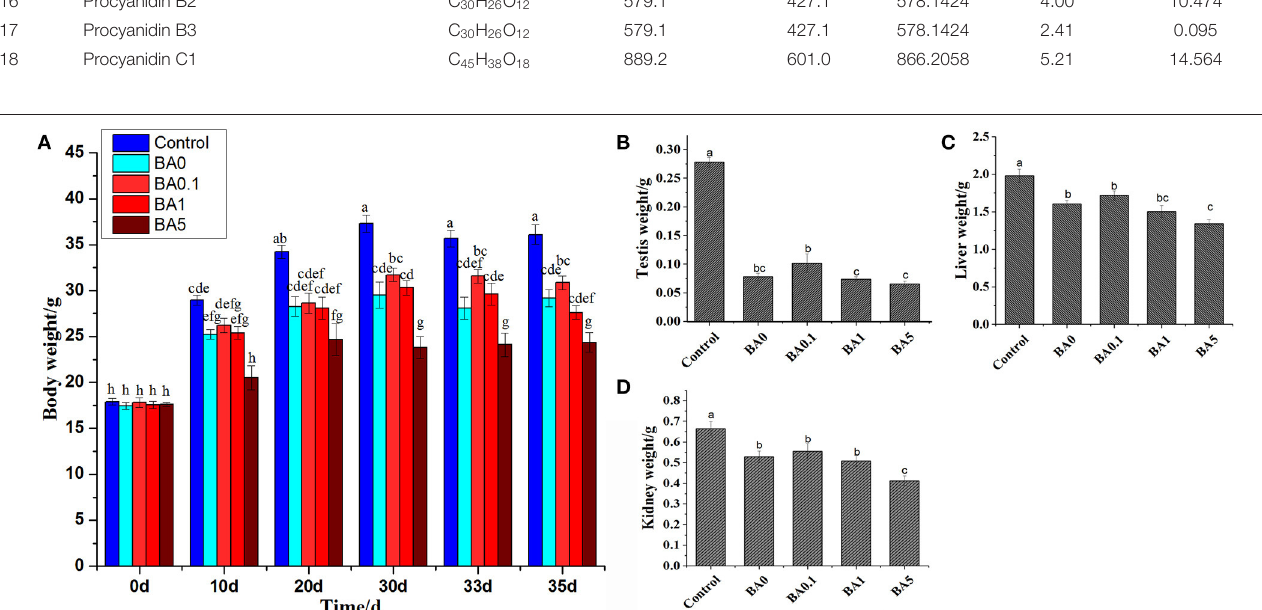
FIGURE 2 | The body and organ weights of mice. (A) Body weight of mice. (B) Testis weight. (C) Liver weight. (D) Kidney weight. Within the samples, values with different letters (a, b, c) are significantly different ( p < 0.05). Body weight was measured 0, 10, 20, 30, 33, and 35 days after anthocyanin extract administration. The weights of testis, liver, and kidney were measured 35 days after anthocyanin extract administration.